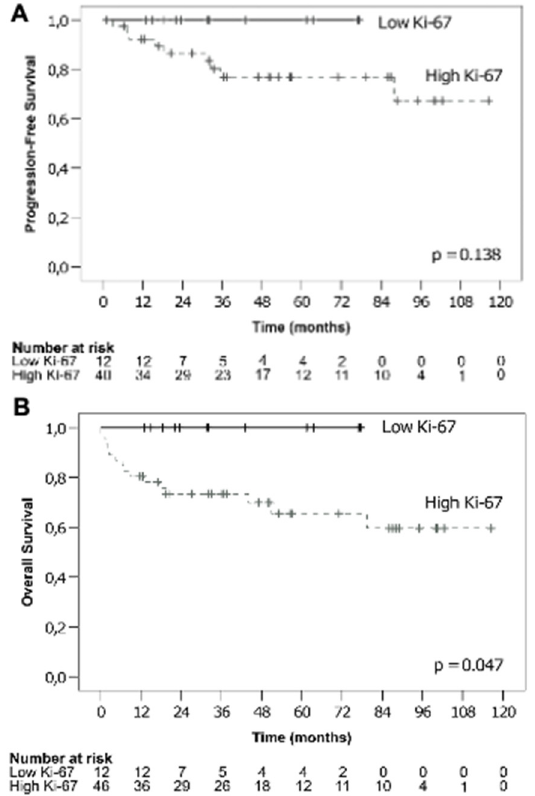
Figure 1. Kaplan–Meier analysis comparing survival rates according to low (continuous line) and high (dashed line) Ki-67. Differences in progression-free survival (PFS) did not reach statistical significance ( A ) and high Ki-67 was associated with worse overall survival (OS) ( B ).